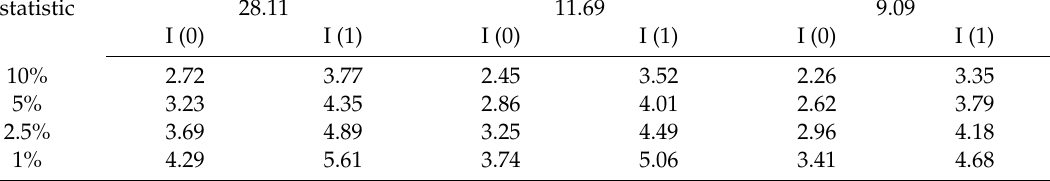
Figure 5. CUSUM and CUSUM of squares test for the linear model.